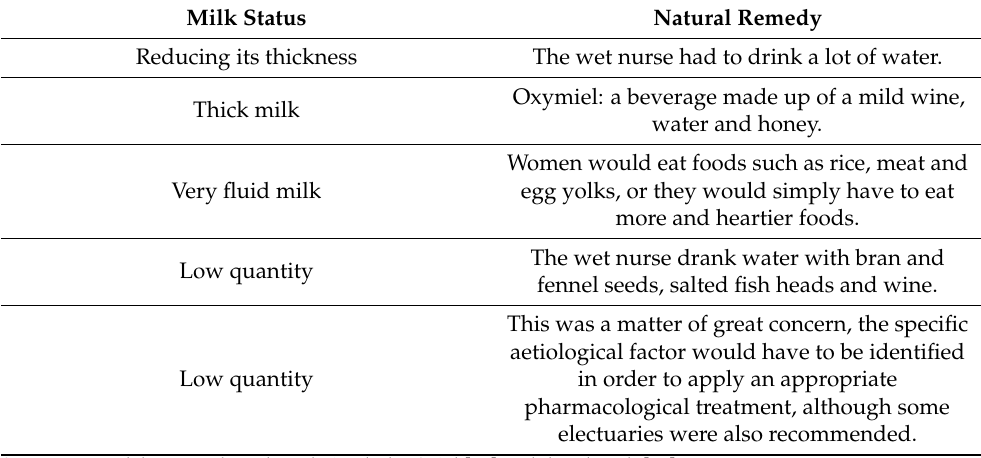
Table 5. Remedies for optimising breast milk condition. Milk Status Natural Remedy Reducing its thickness The wet nurse had to drink a lot of water. Oxymiel: a beverage made up of a mild wine, Thick milk water and honey. Women would eat foods such as rice, meat and Very fluid milk egg yolks, or they would simply have to eat more and heartier foods. The wet nurse drank water with bran and Low quantity fennel seeds, salted fish heads and wine. This was a matter of great concern, the specific aetiological factor would have to be identified in order to apply an appropriate Low quantity pharmacological treatment, although some electuaries were also